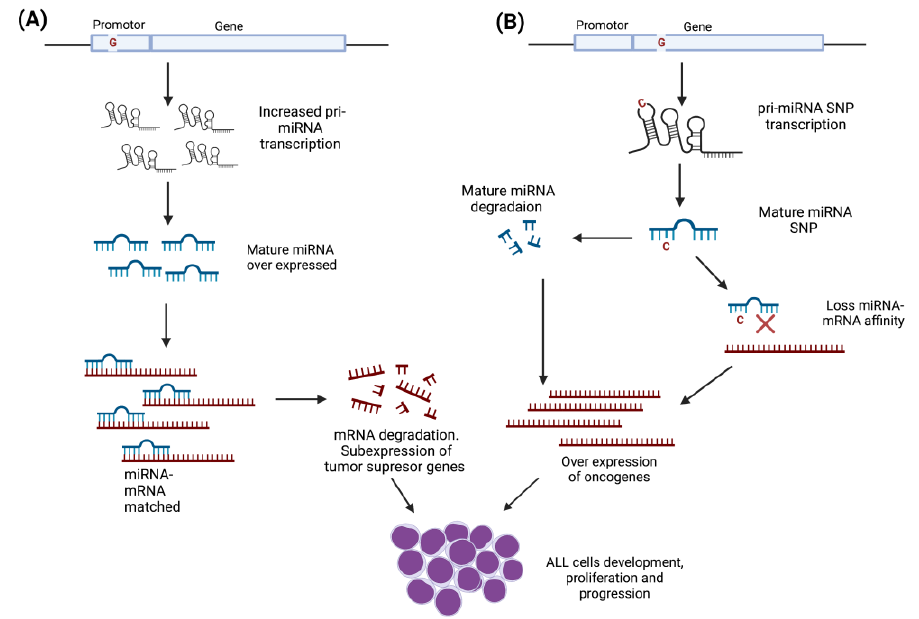
Figure 3. SNPs’ functional effect on miRNAs’ activity. Gene localization of SNPs will determine the effect on miRNA activity. ( A ) SNPs located in the promoter region could modify the expression levels of the mature miRNA, altering the interaction with mRNA target that codes for transcriptional factors involved in the development and differentiation of lymphoid blasts. The interaction between miRNA–mRNA target could promote the subexpression of tumor-suppressor genes, leading to the development, proliferation, and progression of leukemic cells. ( B ) SNPs located on the gene structure would give rise to unstable miRNAs that increase their degradation rate or whose sequence change prevents the miRNA–mRNA target interaction, promoting the overexpression of oncogenes and eventually the progression of leukemic